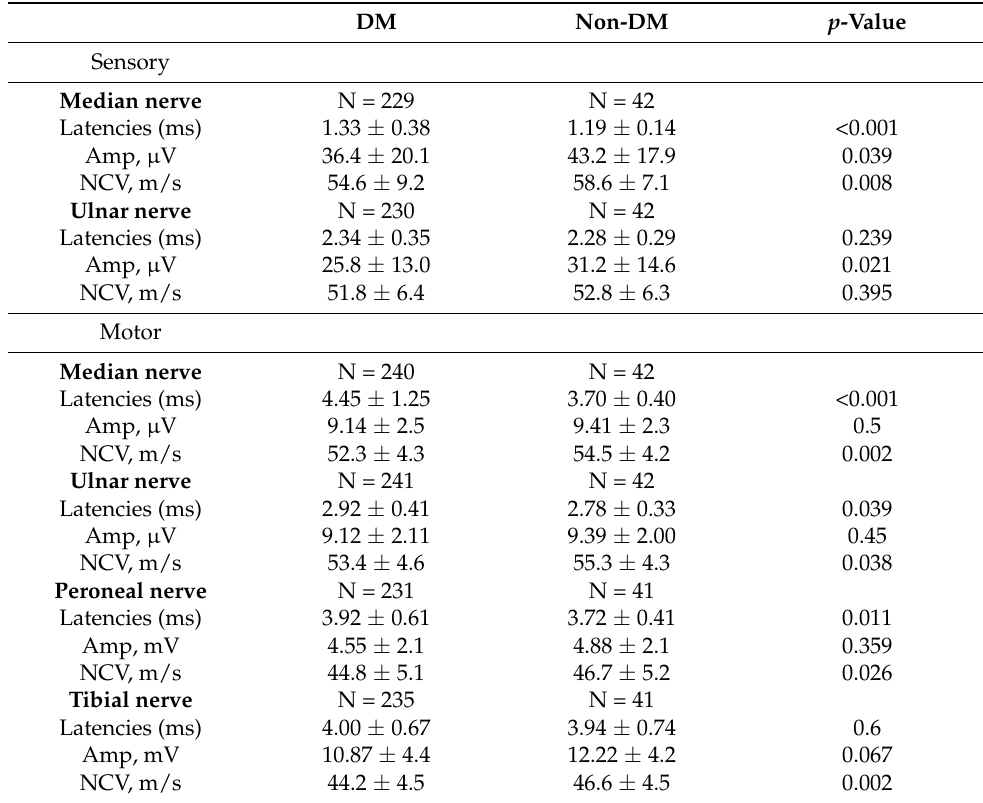
Table 2. Comparisons between DM and non-DM in nerve conduction